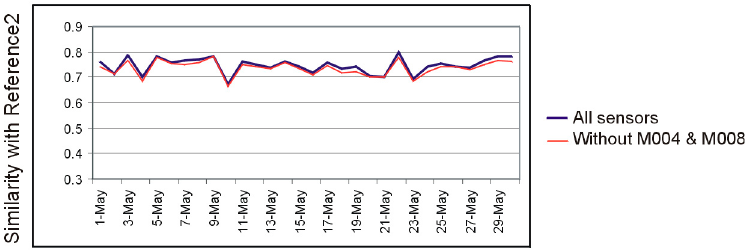
Figure 13. The results of a simulated sensor fault for M004 and M008 versus the results obtained with the original dataset.